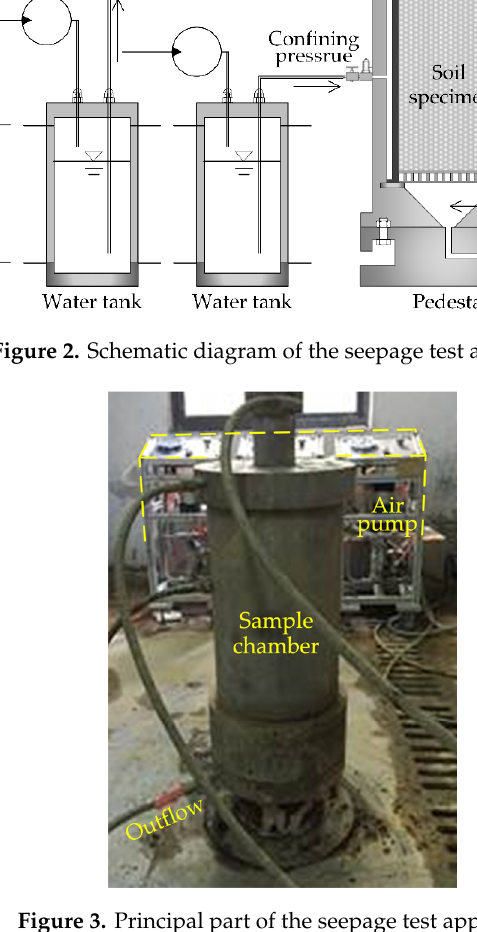
Figure 3. Principal part of the seepage test apparatus.